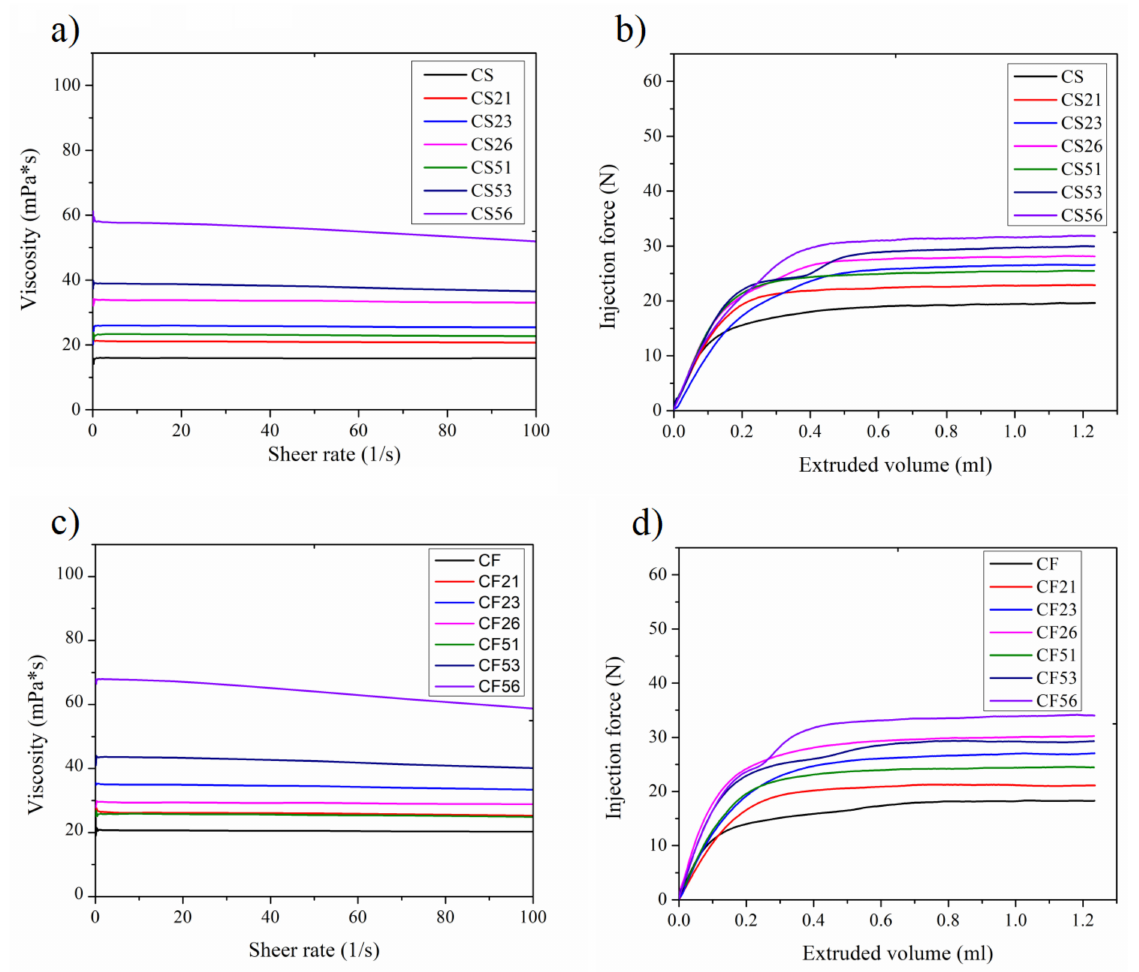
Figure 8. ( a ) Viscosity and ( b ) injectability for soybean oil nanoemulsions (CS21, CS23, and CS26 with 0.1%, 0.3%, and 0.6% of PEG2000-DSPE, respectively; CS51, CS53, and CS56 with 0.1%, 0.3%, and 0.6% of PEG5000-DPPE, respectively); ( c ) viscosity and ( d ) injectability for fish oil nanoemulsions (CF21, CF23, and CF26 with 0.1%, 0.3%, and 0.6% of PEG2000-DSPE, respectively; CF51, CF53, and CF56 with 0.1%, 0.3%, and 0.6% of PEG5000-DPPE,